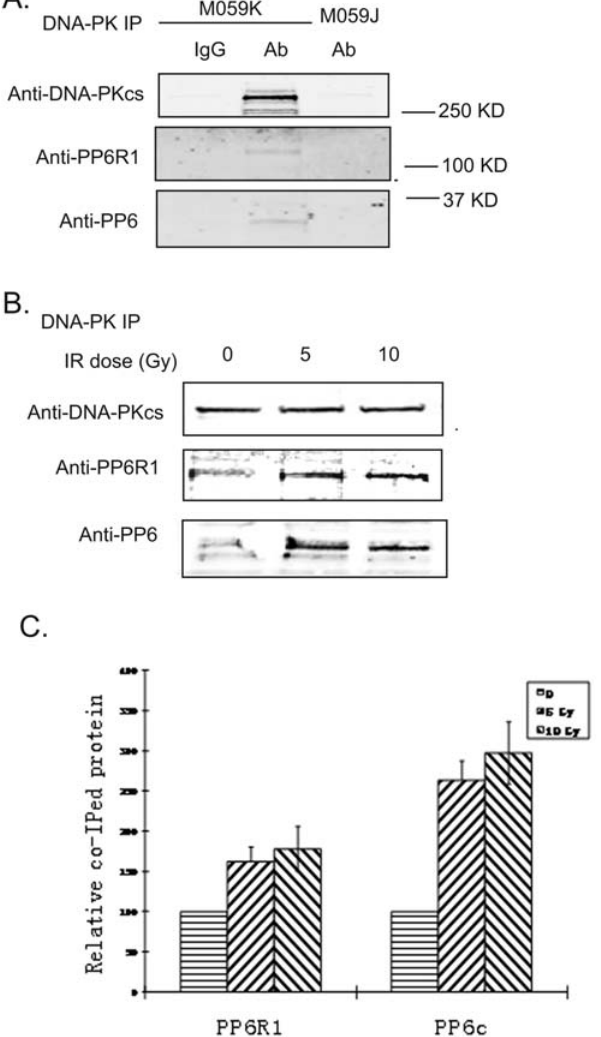
Figure 1. PP6R1 associates with DNA-PK in human cancer cells. A. Cell extracts from irradiated DNA-PK proficient (M059K), and deficient glioblastoma cells (M059J) were immunoprecipitated with monoclonal a -DNA-PKcs antibody. Following SDS-PAGE, DNA-PKcs, PP6R1 and PP6c proteins were detected by immunostaining using specific antibodies or pre-immune serum. B. M059K cells